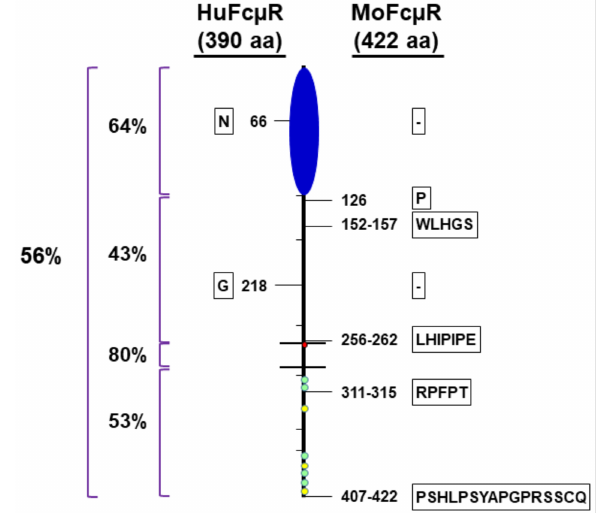
Figure 1. Schematic presentation of homology between human and mouse Fc µ Rs. Fc µ R is depicted as a racquet-like shape consisting of N-terminal Ig-like domain (blue closed oval shape), stalk region (above the top line), transmembrane (between the two lines) and the cytoplasmic tail (below the bottom line). Hatch marks indicate exon boundaries and small red, green and yellow circles indicate a charged His residue in the transmembrane region and conserved five Ser and three Tyr residues in the cytoplasmic tail, respectively. Numbers on the left indicate percentage identity between human and mouse receptors in the overall or indicated regions. The position of aa addition (single letter code within frame) or gap (- within frame) in human (390-aa, left) and mouse (422-aa, right) Fc µ R are shown beside the